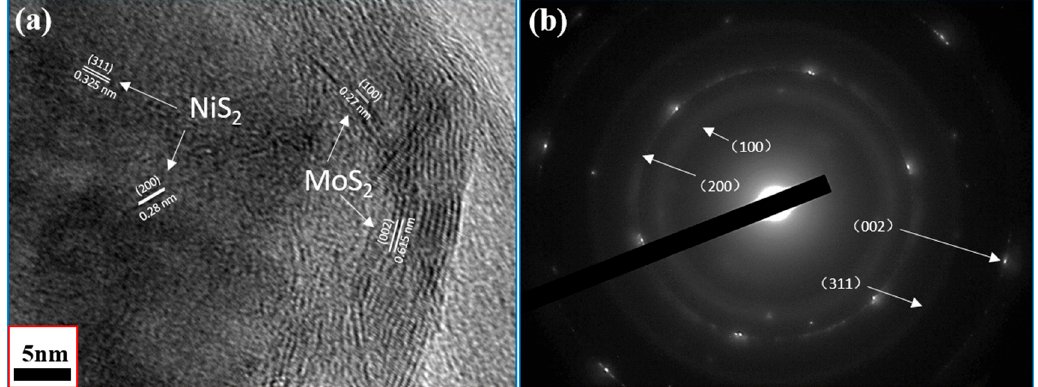
Figure 6. ( a ) HRTEM images and ( b ) SAED pattern of NiS 2 @MoS 2 /rGO composites.